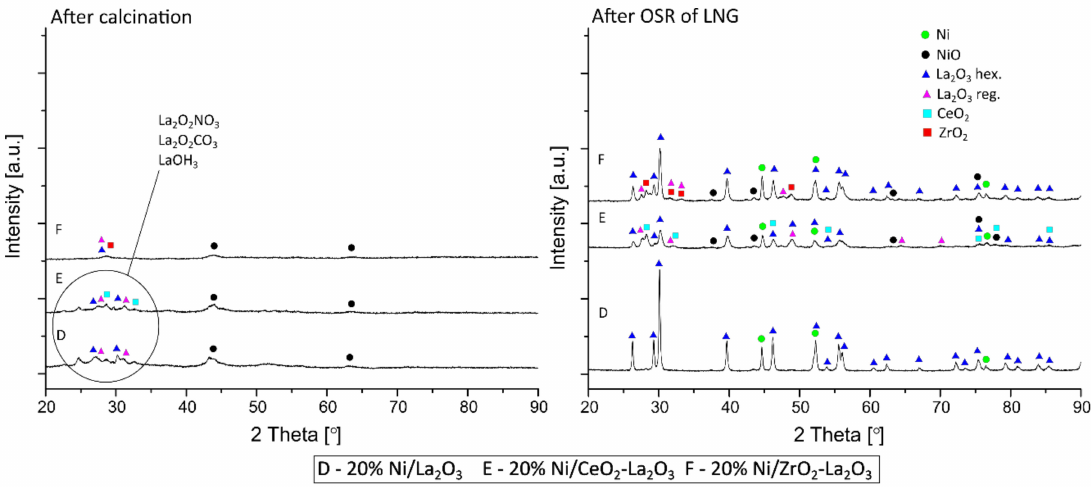
Figure 6. XRD curves of the 20% Ni/La 2 O 3 , 20% Ni/5% CeO 2 –La 2 O 3 and 20% Ni/5% ZrO 2 –La 2 O 3 catalysts calcined in an air atmosphere for 4 h at 400 ◦ C and spent in the oxy-steam reforming of